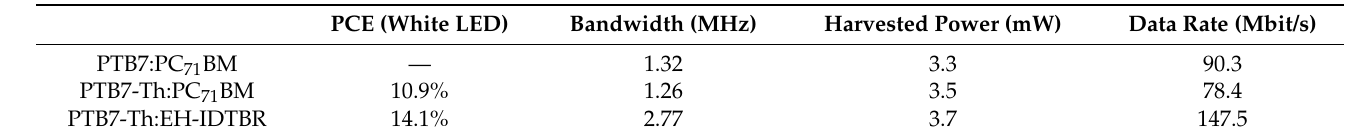
Table 3. Obtained communication and indoor energy harvesting performances for different OPVs in a SISO configuration. Adapted with permission from reference